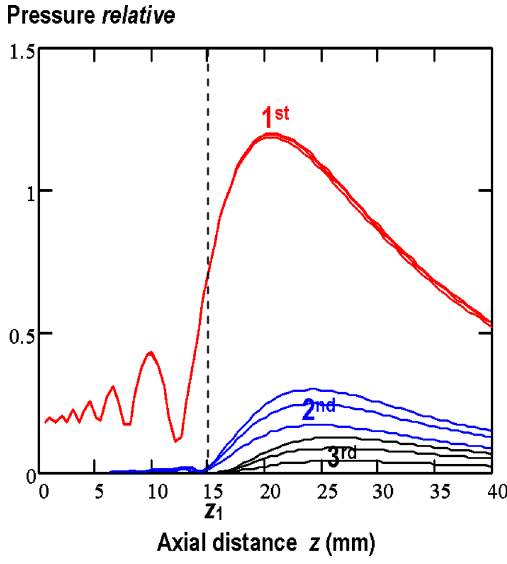
Figure 4. Calculated axial pressure variations of the 1 st , 2 nd and 3 rd harmonic component for the pulsed nonlinear sound beam produced in water by 20-cycle tone bursts with a 0.2 duty-cycle and the initial acoustic pressure amplitude of 0.335 MPa, 0.475 MPa and 0.585 MPa.